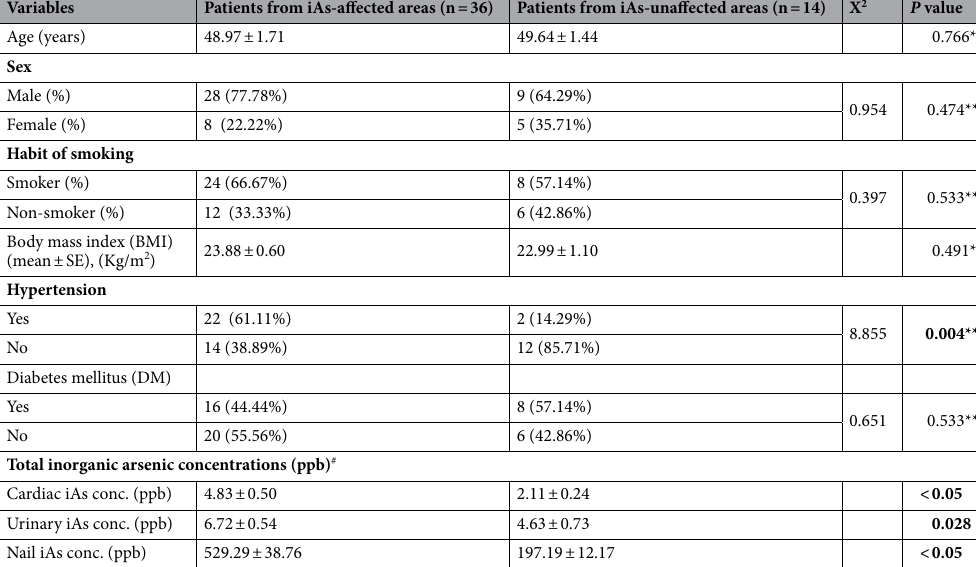
Table 1. Distribution of study population characteristics (n = 50). The P values in ‘bold’ are significant. The significance level is P < 0.05. * Age and BMI were shown as mean ± SE and analyzed by Student’s t test. **Sex, habit of smoking, Hypertension and Diabetes Mellitus (DM) were shown as percent and analyzed by Chi- square test. # The values of iAs concentrations were shown as mean ± SE and analyzed by Student’s t test.